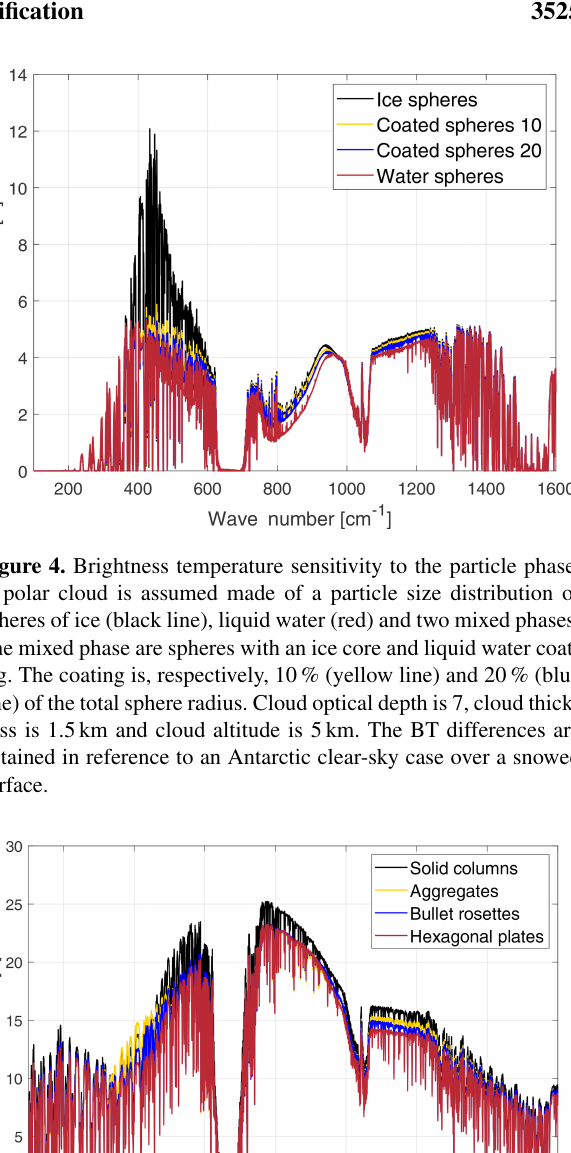
ferent cases in the tropical atmosphere: a sub-visible cirrus cloud (black line), the clear-sky case with a 3 K decrease in skin surface temperature (yellow line) and the clear-sky case with an increase of 10 % along the vertical profile of the water vapour mixing ratio (blue line). The cirrus is as- sumed to be composed of plates with an effective dimension of 20 µm, optical depth OD = 0 . 03 and geometrical thick- ness 1 km. Results show distinctive spectral features due